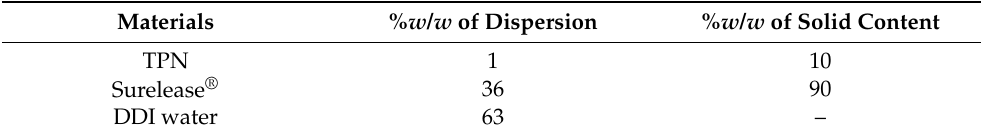
Table 3. Composition of TPN-EC membrane coating